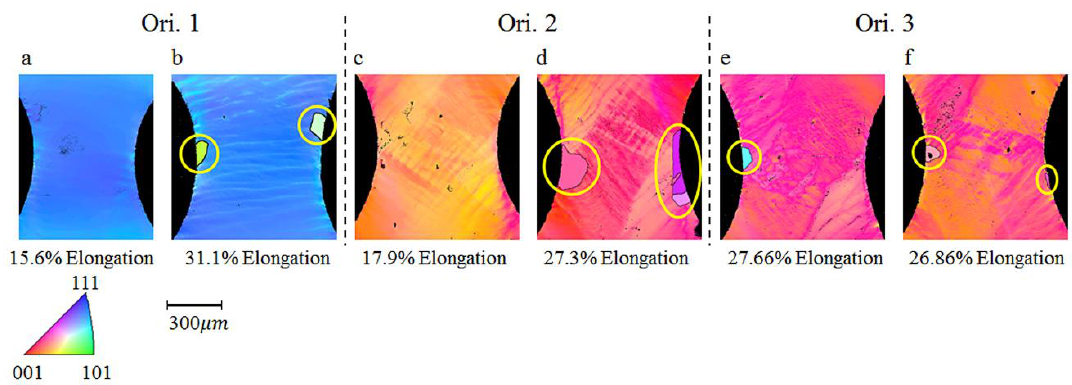
Figure 14. EBSD measured inverse pole mapping of ( a ) 1-1 annealed for 60 min; ( b ) 1-2 annealed for 5 min; ( c ) 2-1 annealed for 60 min; ( d ) 2-2 annealed for 30 min; ( e ) 3-1 annealed for 15 min; and ( f ) 3-2 annealed for 10 min. Grain boundaries were labeled with solid black lines. These mappings have indicated approximate locations of nucleation sites. Yellow circles pointed out nucleation sites at the first stage of recrystallization. Dashed lines were used to separate specimens with different initial orientations.